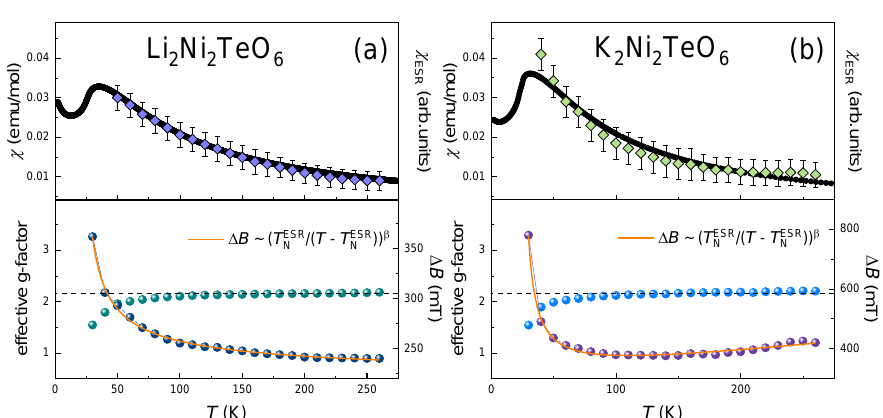
Figure 3. The temperature dependence of the main ESR parameters of ( a ) K 2 Ni 2 TeO 6 and ( b ) Li 2 Ni 2 TeO 6 derived from fitting the absorption line with the Lorentzian profile: the integral ESR intensity is shown in the upper panel, and the effective g -factor and the ESR linewidth, ∆ B , in the lower panel. The orange solid curves represent an approximation in accordance with a modified Huber theory (Equation (5)), as described in the text for ( a ), and in the framework of Kawasaki – Mori – Huber theory (Equation (6)) for ( b ).